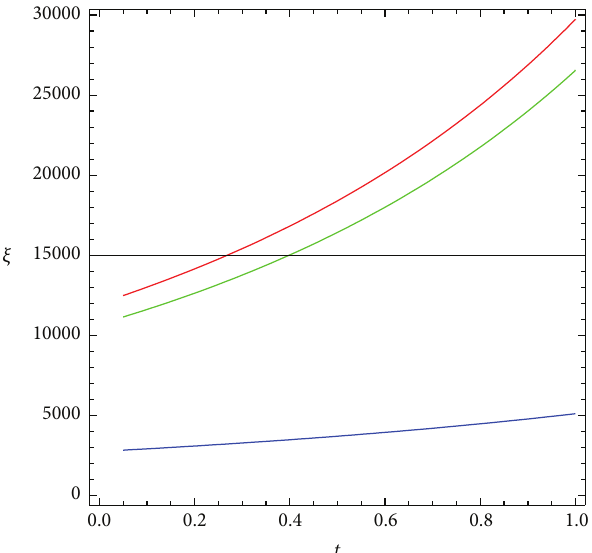
Figure 4: Plot of the bulk viscosity coefficient 𝜉 . Red, green, and blue lines correspond to {𝛼,𝛽} combination of {0.9735, 3701} with 𝜂 = 3.5 × 10 −4 , 3.0 × 10 −4 , and 2.5 × 10 −4 , respectively.